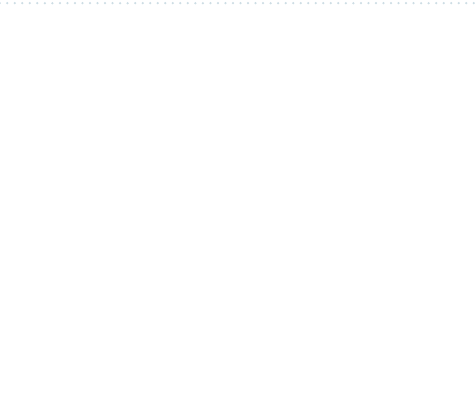
Figure 3. Change in central retinal thickness (CRT) ( a ) and central choroidal thickness (CCT) ( b ) from baseline. In the comparison between the two groups, the rate of change in CRT and CCT was significantly increased in the PAEM group at 3 days after PDT, with no significant difference at 1 month (CRT and CCT: 3 days, p < 0.05 and p < 0.05; 1 month, p = 0.17 and p = 0.21).